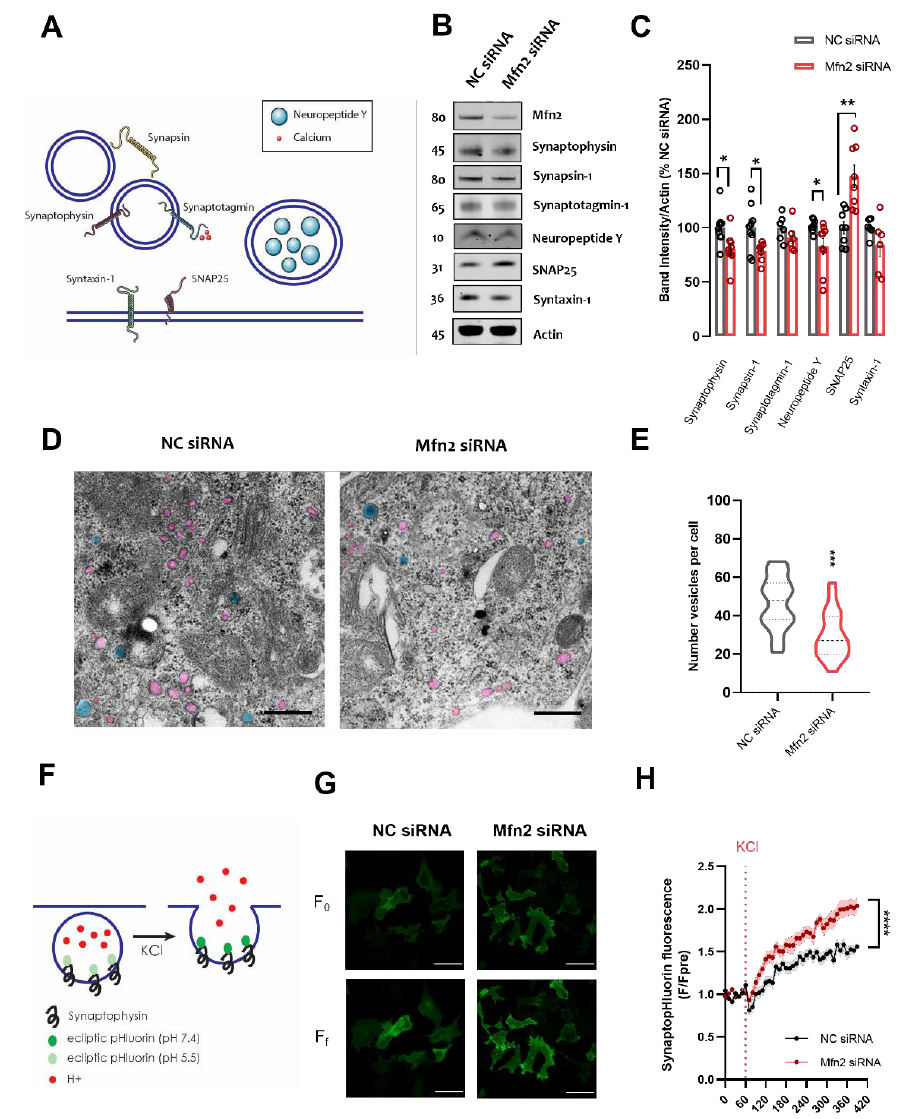
Figure 2. Mfn2 down-regulation decreases vesicular protein levels and vesicle number, while in- creasing SNARE SNAP25 protein levels and SynaptopHluorin (SypHy) fluorescence. ( A ) Schematic representation of some of the proteins involved in vesicular release mechanisms. ( B ) Representative immunoblots of NC siRNA or Mfn2 siRNA SH-SY5Y cell homogenates. Blots were probed with antibodies against Mfn2, Synaptophysin, Synapsin-1, Synaptotagmin-1, Neuropeptide Y, SNAP25, Syntaxin-1 and actin which was used as a loading control. ( C ) Bar graph shows the amounts of protein analyzed once standardized to actin content in each sample ( n = 6–9 independent cultures). ( D ) Representative TEM pictures of NC siRNA or Mfn2 siRNA SH-SY5Y cells showing vesicles (pink) and dense core vesicles (blue). Scale bar = 500 nm. ( E ) Violin plots show quantification of number of vesicles per cell (four independent cultures, five cells analyzed per culture). ( F ) Schematic representation showing the mode of action of SypHy construct upon KCl depolarization. ( G ) Rep- resentative confocal images of SH-SY5Y cells treated with NC siRNA or Mfn2 siRNA. Panels show initial fluorescence (F 0 ) and final fluorescence (F f ). Scale bar = 10 µ m. ( H ) Graph shows normalized SypHy fluorescence over time in NC siRNA or Mfn2 siRNA, each timepoint. ( F ) was normalized to average pre-stimulation fluorescence levels (F pre ). After one minute of basal recording, cells were depolarized with 50 mM KCl ( n = 18–19 cells from 4 independent cultures). The ratiometric difference between F f /F 0 was shown to be significant p ≤ 0.0001. * p ≤ 0.05, ** p ≤ 0.01, *** p ≤ 0.001, **** p ≤